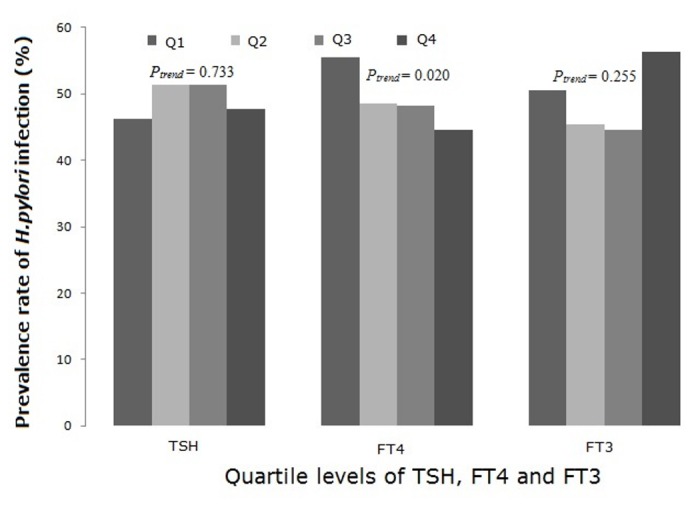
Prevalence of Helicobacter pylori infection according to thyroid function.Subjects were classified into different groups according to their TSH, FT4, and FT3 quartiles. The prevalence of H. pylori showed a decreasing trend as serum FT4 increased, while the trend was not significantly associated with serum TSH or FT3 levels. P-values were adjusted for age, gender and BMI status.